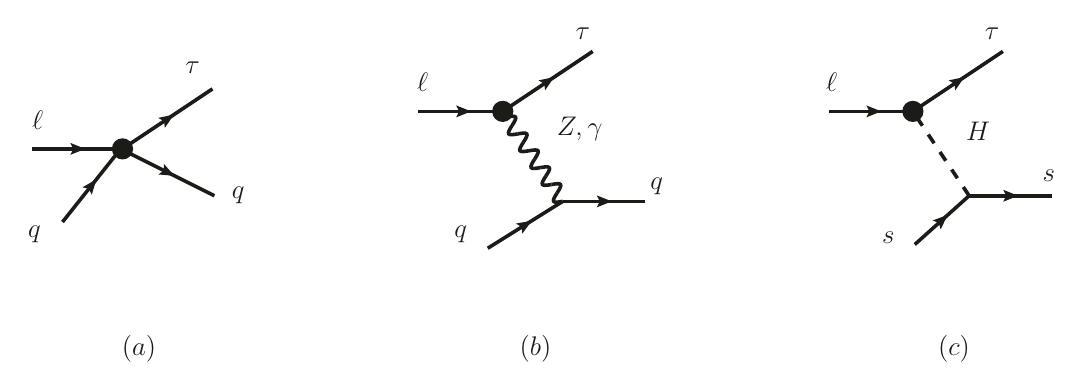
Figure 3 . Different contributions of the SMEFT Lagrangian to ‘q → τq for ‘ = e, µ and q = u, d, s . The dot indicates the CLFV vertex. We consider m u = m d = 0 but m s 6 = 0 . Hence, the contribution of the Higgs in (c) only exists for q = s .